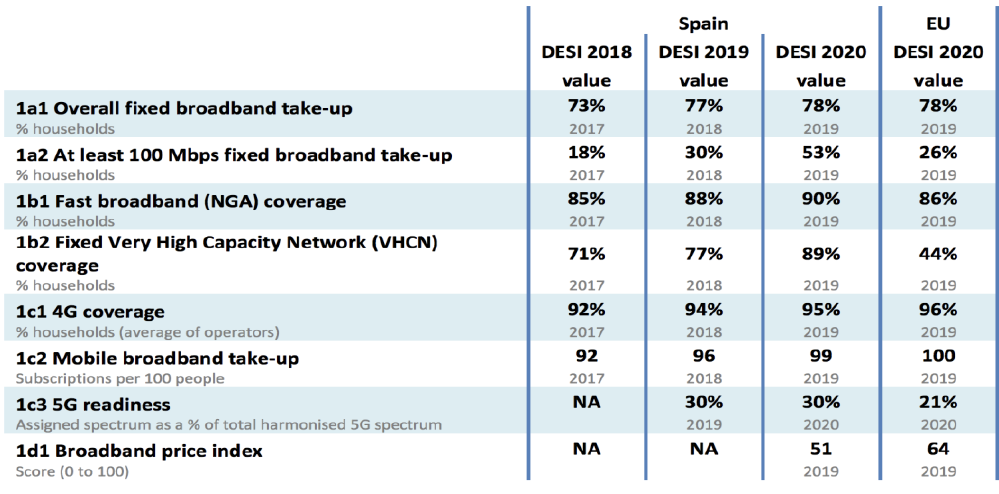
Figure 3: Connectivity (EU-28) (Source: European Commission 2021a)